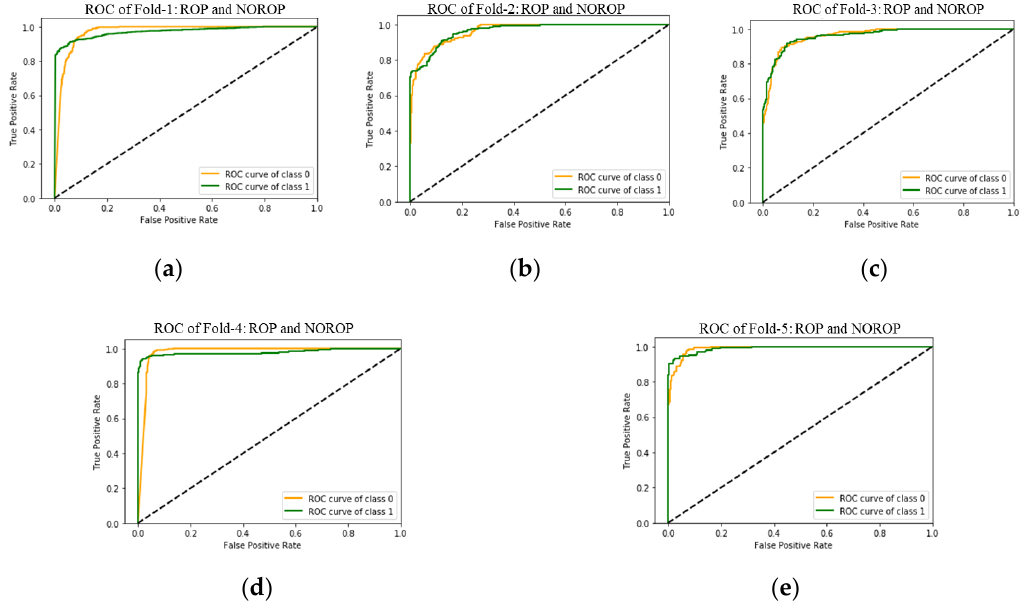
Figure 7. ROC curves for each of the 5 folds of data ( a – e ) obtained using the VGG19 classification model. The orange and green ROC curves in individual plots represent class 0 (NOROP) and class 1 (ROP), respectively. Table 6. Performance evaluation of the 5-fold cross-validation of the VGG19 model.